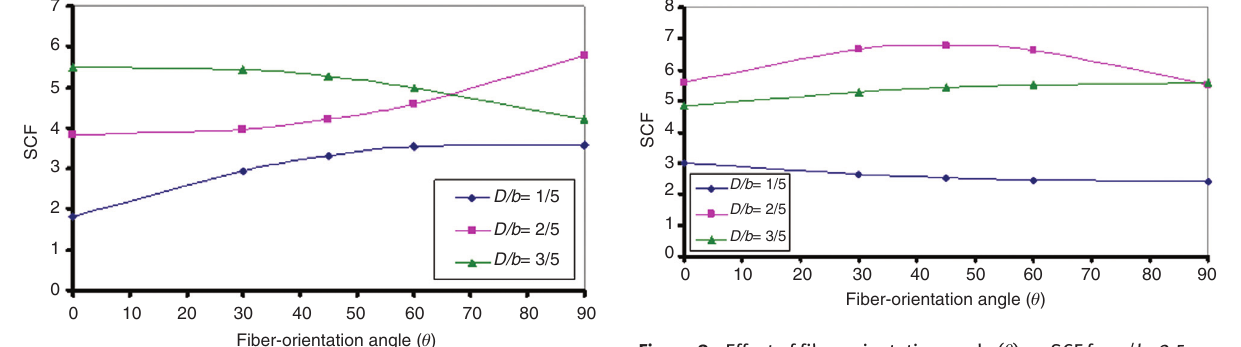
Figure 8 Effect of fiber orientation angle ( θ ) on SCF for a / b = 2.5 using graphite/epoxy material.